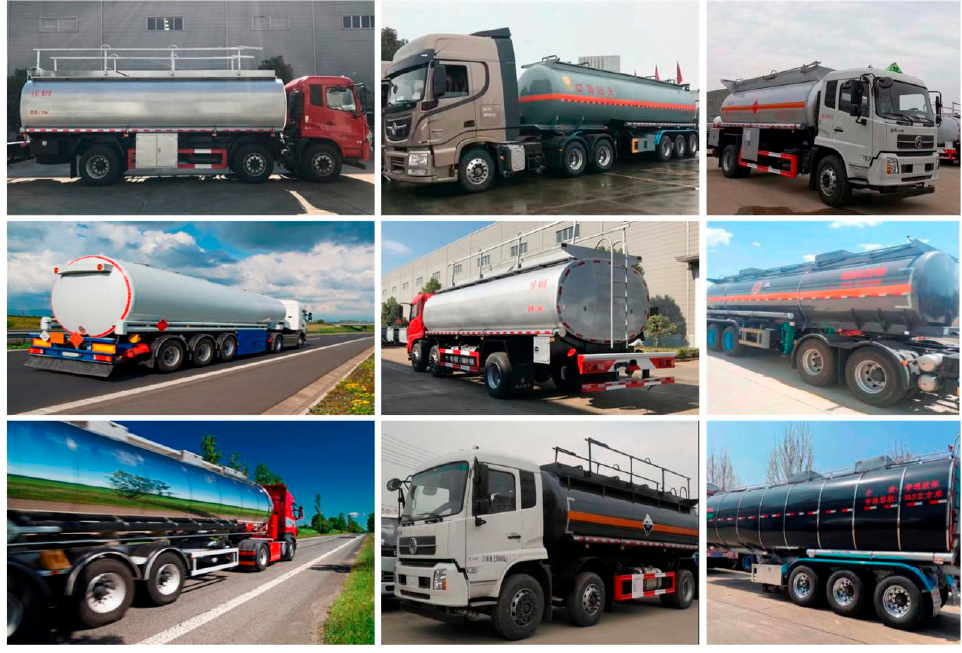
Figure 3. Vehicle data set.